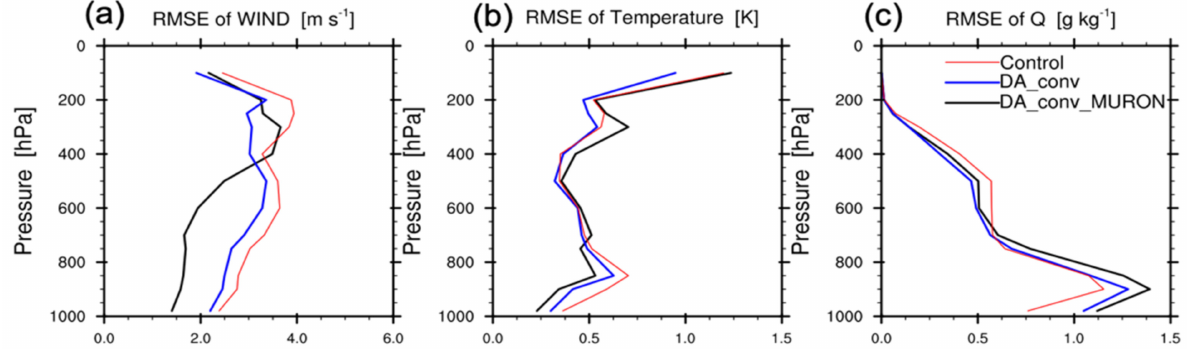
Figure 7. Averaged vertical profile of RMSE of ( a ) wind speed, ( b ) temperature, and ( c ) water vapor mixing ratio for the DA_CONV analysis (blue line), the DA_CONV_MURON analysis (black line), and the control run (red line) over the 500 km × 500 km box centered on the TC for all DA